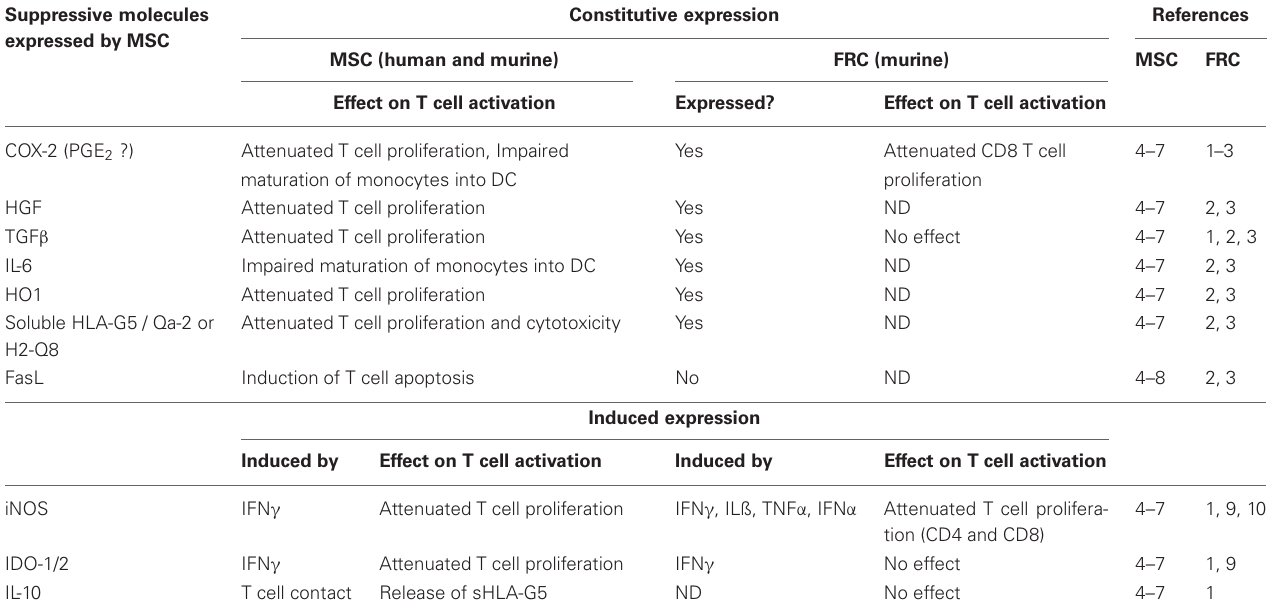
Table 1 | Suppressive molecules known to be expressed in MSC versus their characterization in FRC. Suppressive molecules expressed by